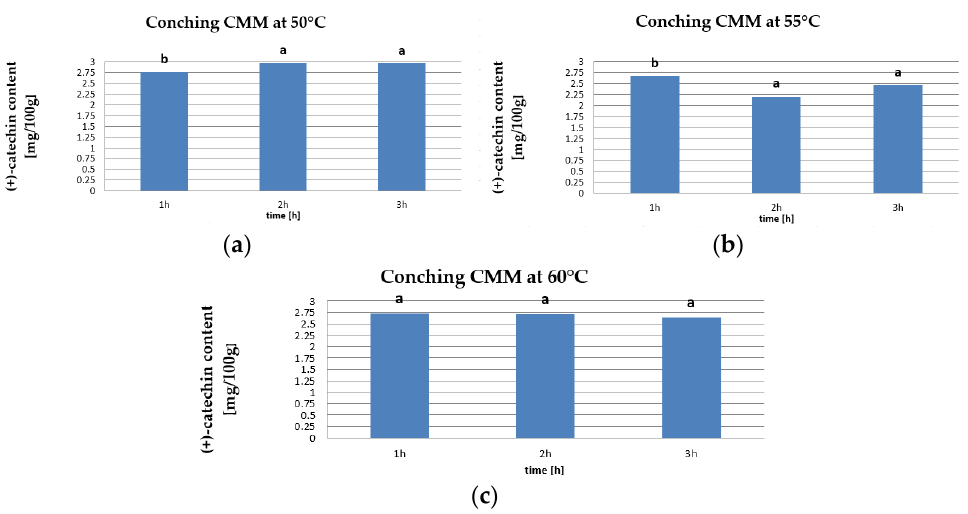
Figure 2. Catechin content in CMM at conching temperatures ( a ) 50 °C, ( b ) 55 °C, and ( c ) 60 °C (the same letters mean that there are no statistically significant differences between the values of this indicator at a confidence level of α = 0.05).